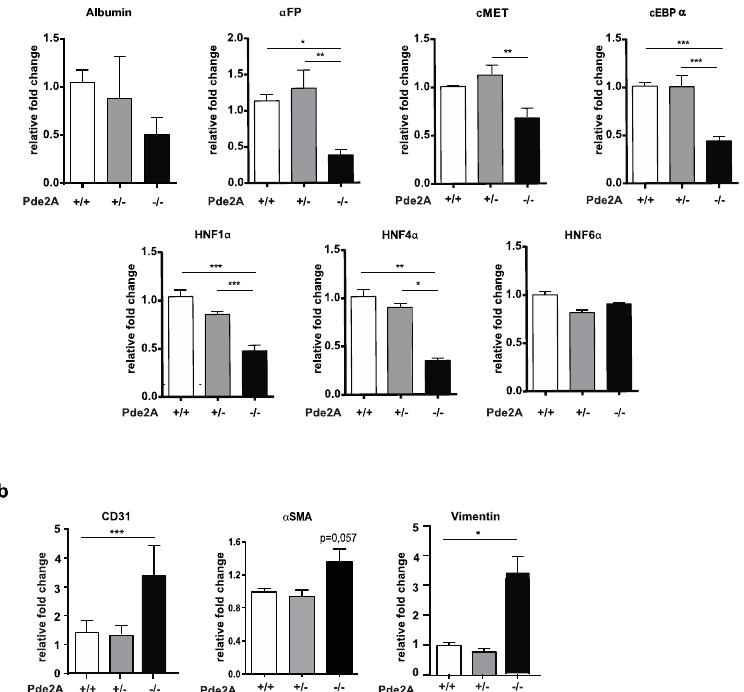
Figure 2. Transcript modulation in liver maturation of PDE2A − / − embryos. qRT-PCR in E14.5 liver embryos shows reduction of expression of liver differentiation markers and increase of stromal and endothelial markers relative to GAPDH expression. ( a ) Relative mRNA level of albumin, α-fetoprotein and transcription factors cMET, cEBPα, HNF1, HNF4 and HNF6 in liver of PDE2A −/− embryos. ( b ) Relative mRNA level of CD31, vimentin and α-SMA in liver of PDE2A − / − embryos. At least N = 3 embryos/genotype were analyzed in each experiment. * P < 0.05; ** P < 0.01; *** P < 0.001.